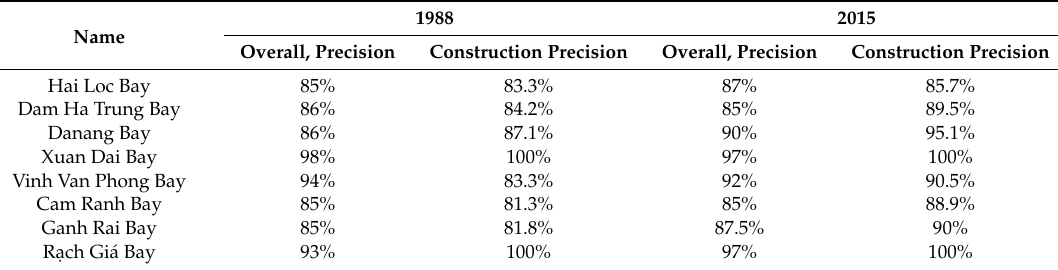
Table 4. The precision of the classification.